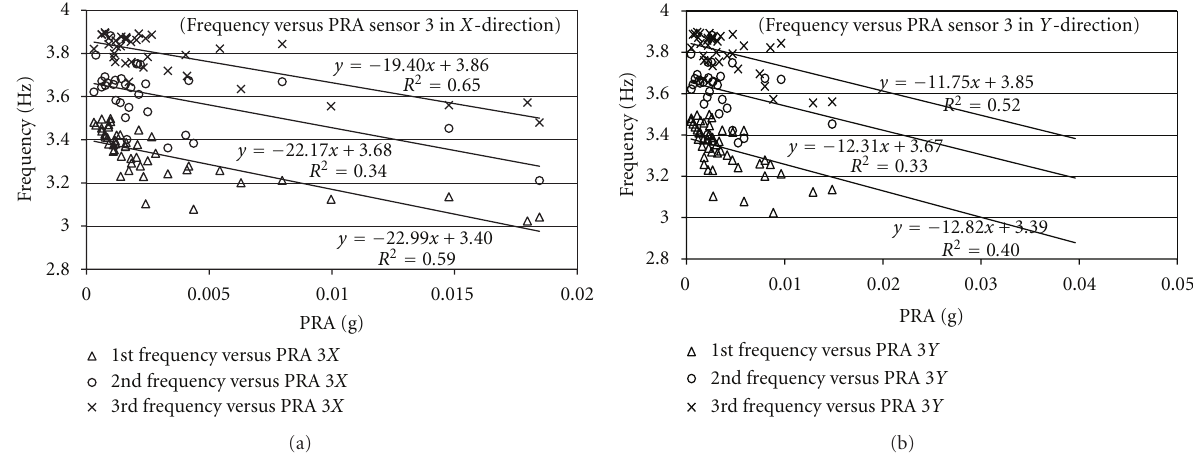
Figure 13: First three modal frequencies of building A for flexible base case versus PRA of sensor 3: (a) X -direction and (b) Y